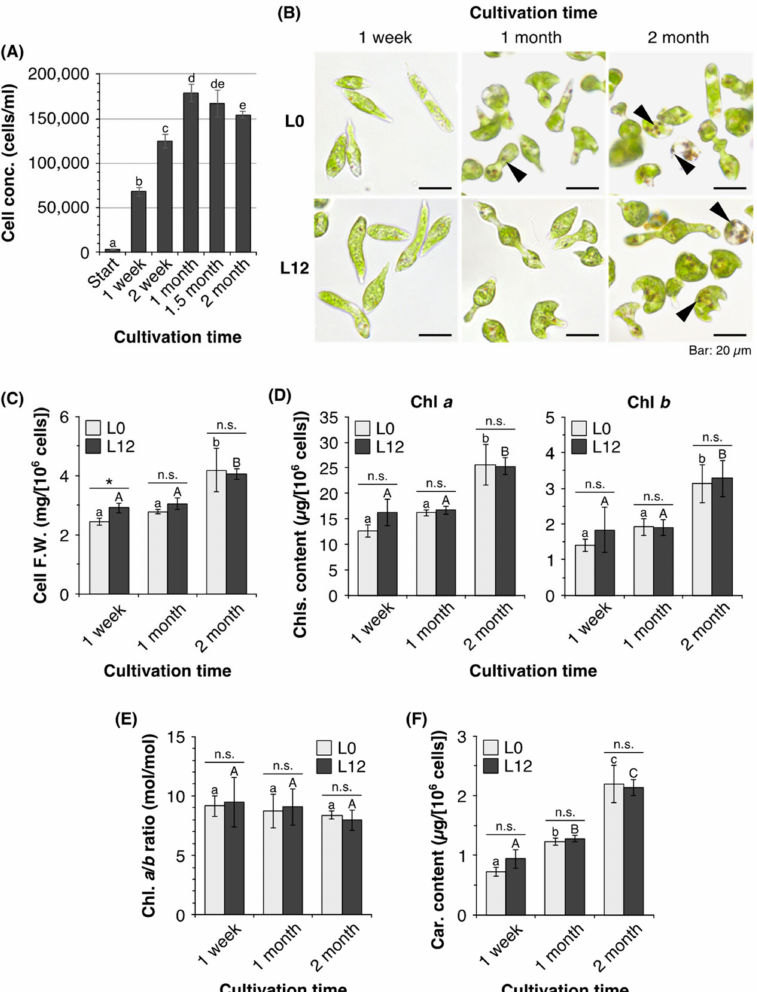
Figure 1. Characterization of Euglena gracilis cells in cultures of different ages. ( A ) Time course of cell concentrations of E. gracilis cells grown under 12 h/12 h light/dark cycles for 2 months. Data are means ± SD ( n = 5). ( B ) Appearance of E. gracilis cells grown under 12 h/12 h light/dark cycles for 2 months. Algal cells were observed under a bright-field microscope at the beginning (L0) and the end (L12) of the light period after 1 week, 1 month, and 2 months in culture. Arrowheads indicate pigmented brown globules within cells. ( C – F ): ( C ) Cell fresh weight; ( D ) chlorophyll a and b content; ( E ) chlorophyll a : b ratio; and ( F ) total carotenoid content of cells from 1-week-old and 1- or 2-month-old cultures. Data are means ± SD ( n = 3). Bars labeled with the same letter do not differ significantly from one another (Tukey’s multiple range test, p < 0.05). n.s.: not significant; *: p < 0.05 ( t